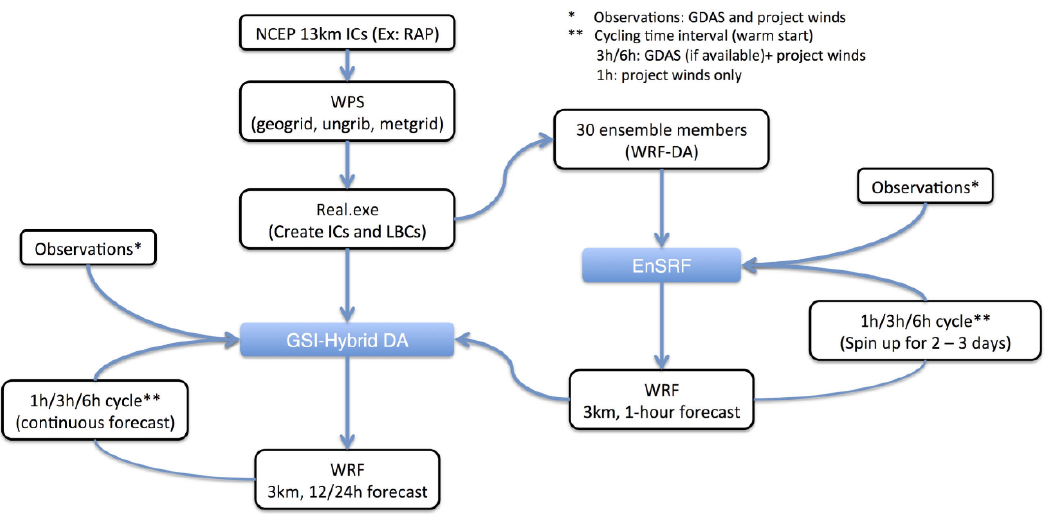
Figure 5. Diagram of advanced assimilation system UCD_WRF-GSI.